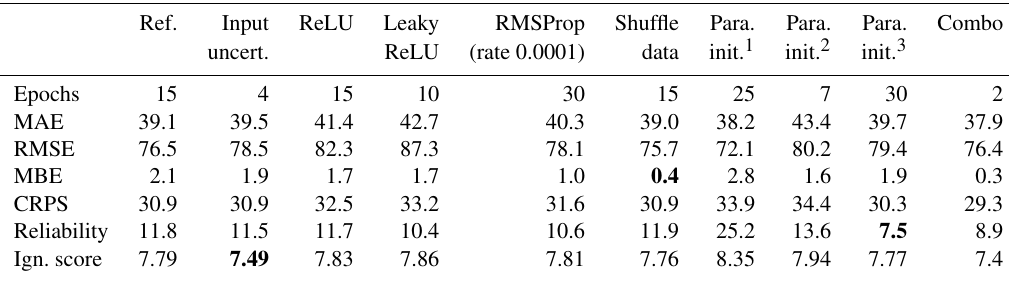
Parameter initialization 2 and 3 is as in Table